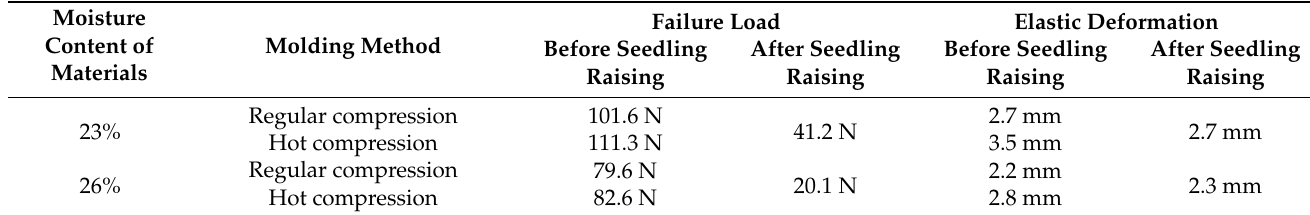
Table 3. Bending strength and elastic deformation of seedling